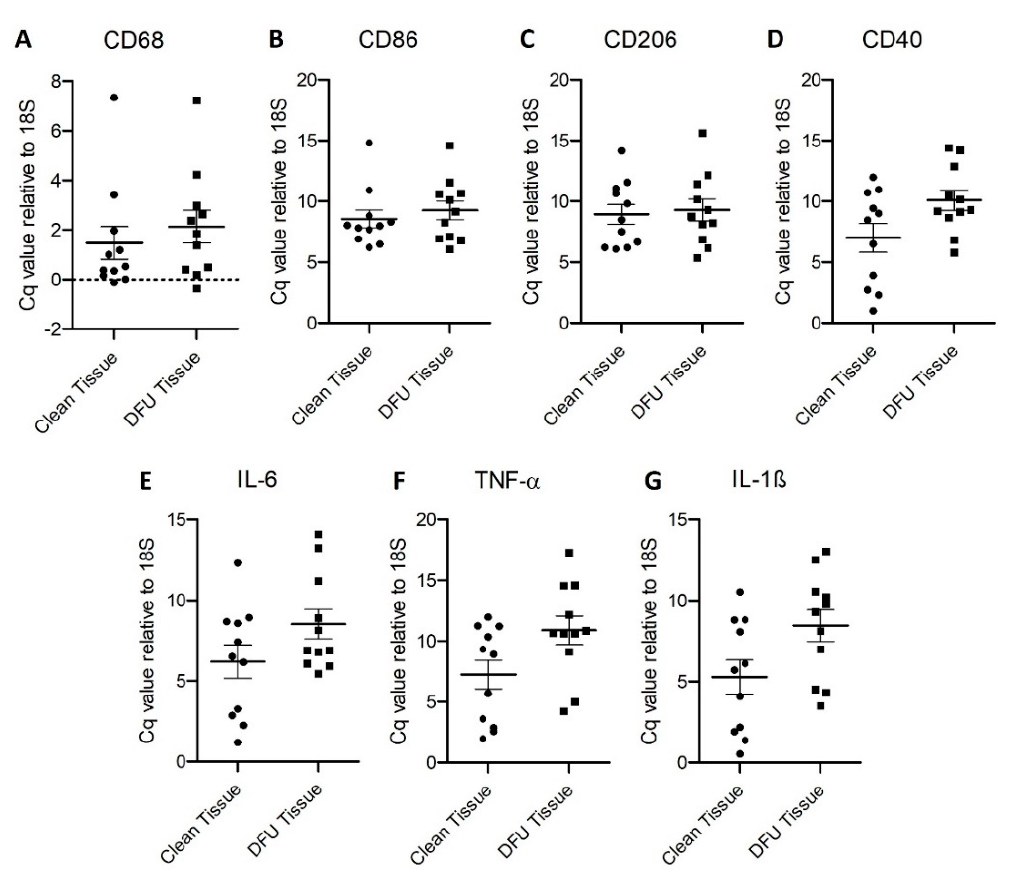
Figure 6. Real-time Polymerase Chain Reaction (RT-qPCR) for CD68 ( A ), CD86 ( B ), CD206 ( C ), CD40 ( D ), interleukin (IL)-6 ( E ), IL-1 β ( G ), and tumor necrosis factor (TNF)- α ( F ). All data are presented as mean ± SEM ( n = 11 in each